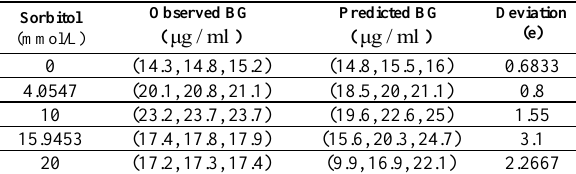
Table 11. Predicted BG content and deviations for